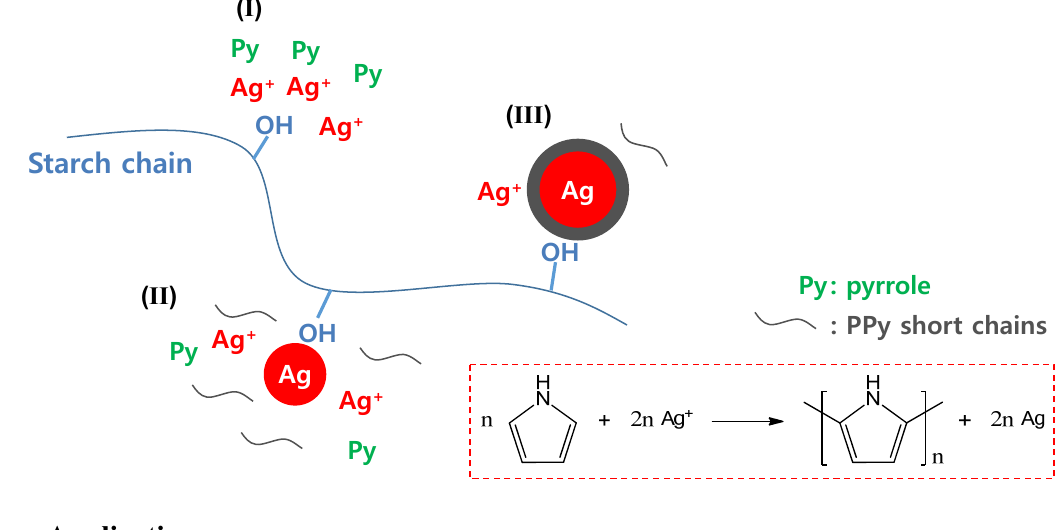
Figure 5. Schematic illustration of the formation mechanism of Ag-PPy nanoparticles: the reaction process could be divided into three stages (I, II, and III). Right bottom: the scheme describing the chemical reaction between pyrrole and silver cation. With permission from [47]; Copyright 2012, American Chemical